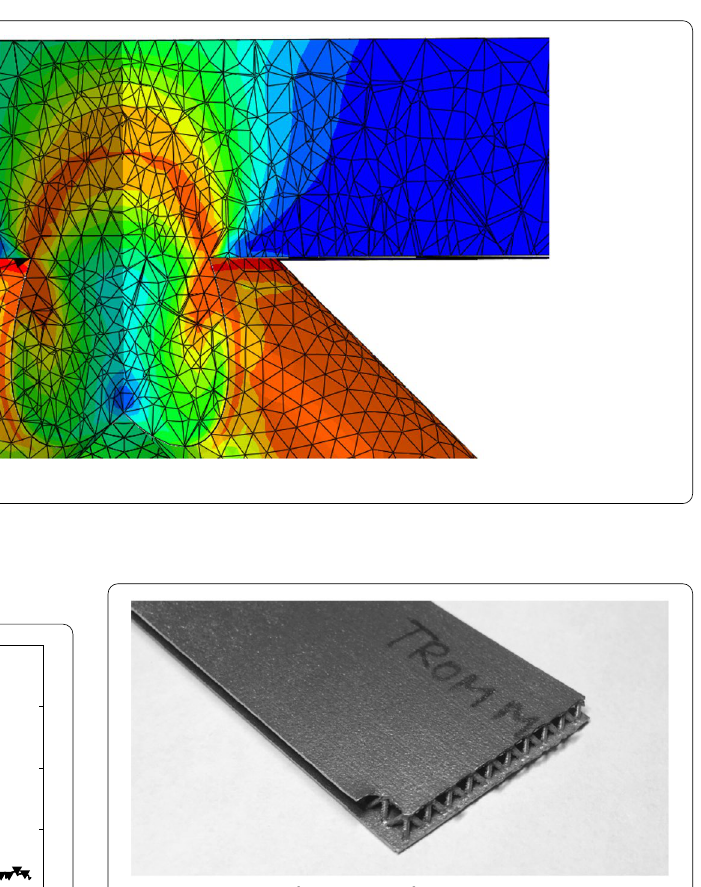
Figure 19 Pictures of specimen 1 after